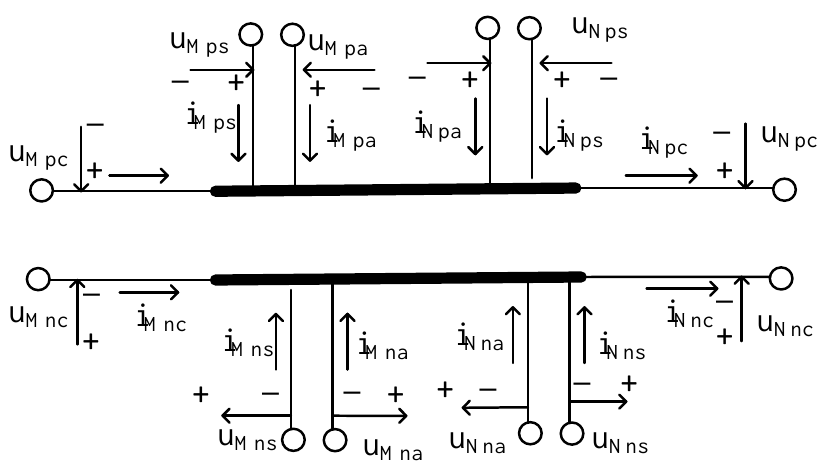
Figure 1. Equivalent circuit of bipolar cable.